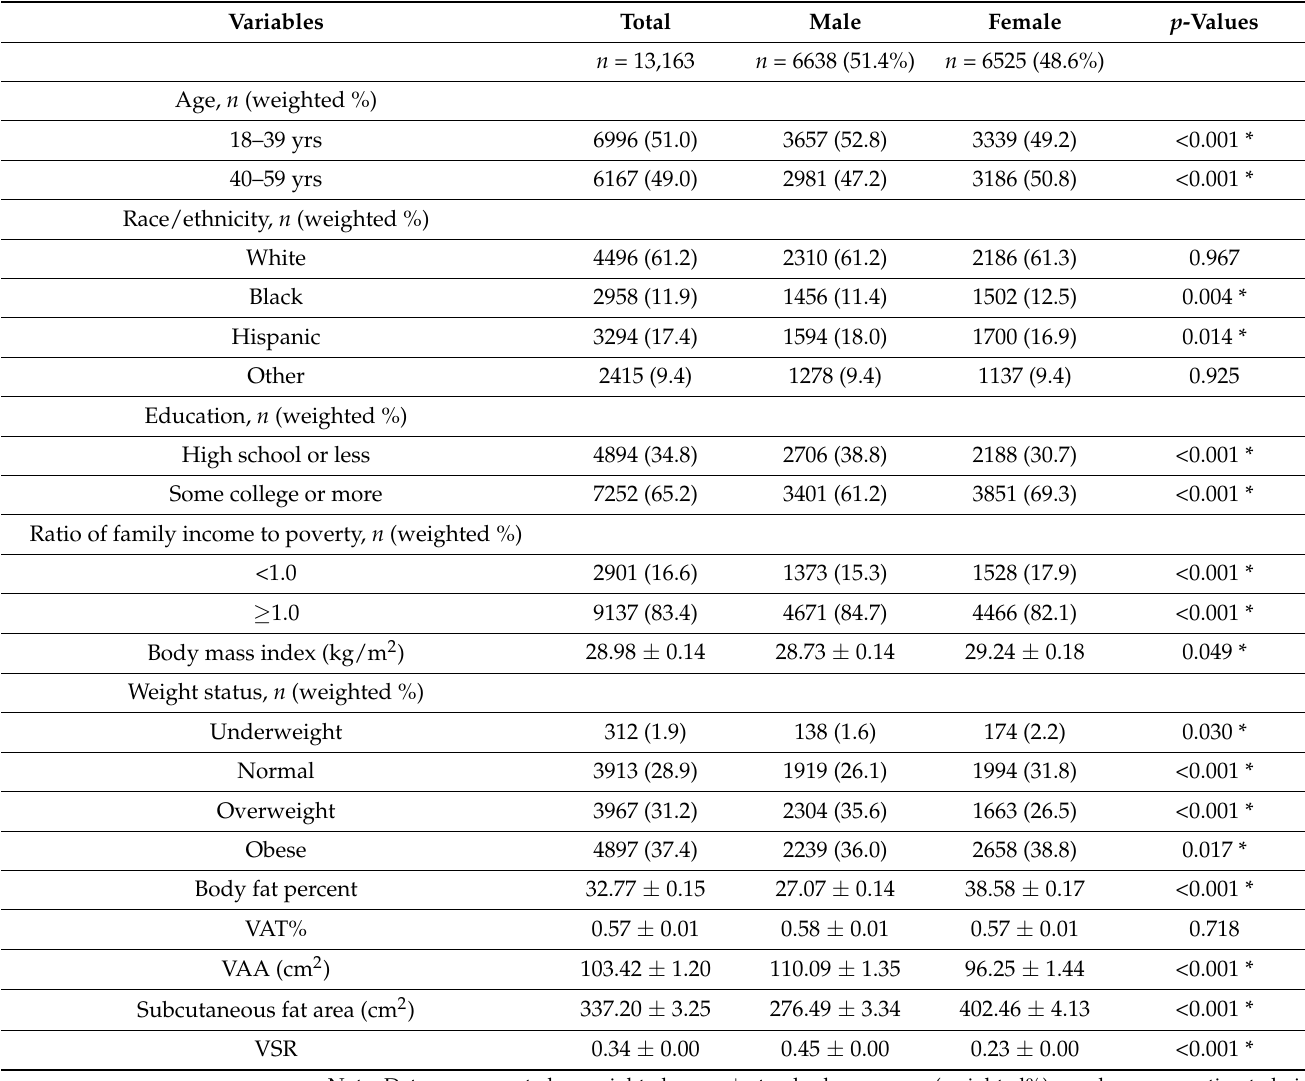
Table 1. Demographics stratified by sex, NHANES